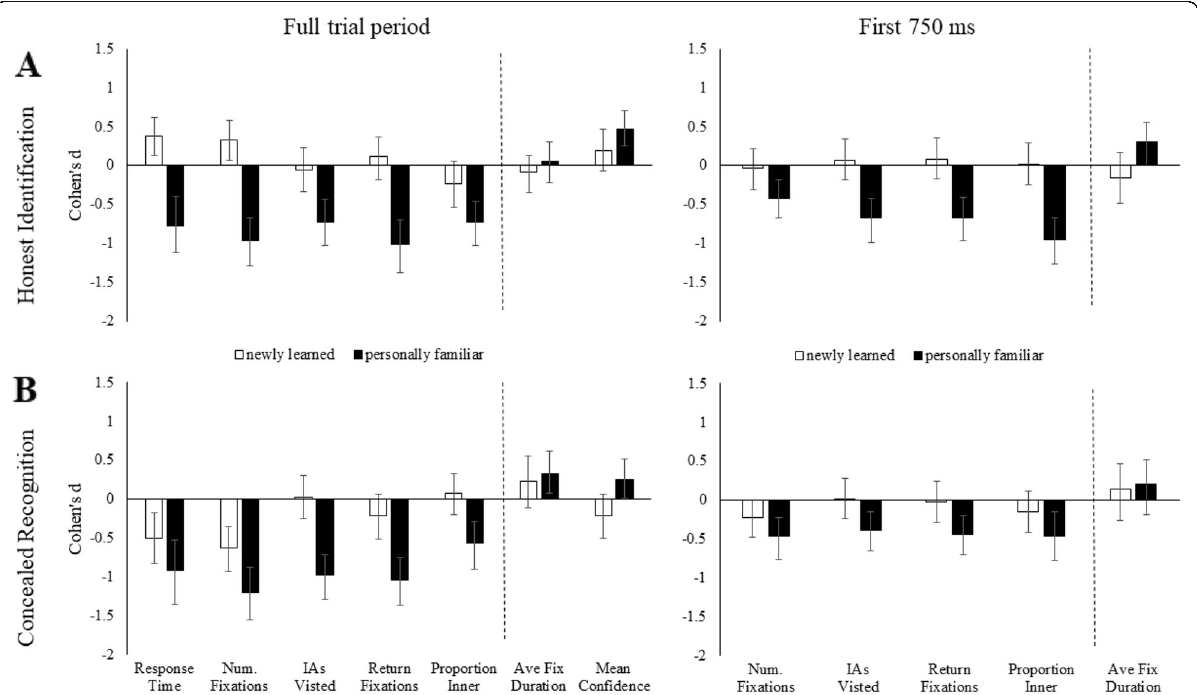
Fig. 3 Cohen ’ s d effect size differences (95% CIs) for faces in Experiment 1 a honest identification of familiar faces compared to unfamiliar faces, b concealed recognition of familiar faces compared to unfamiliar faces. On the left , data shown for the Full trial period are Response Times, Num. Fixations, IAs Visited, Return Fixations, Proportion Inner, Ave Fix Duration, Mean Confidence. On the right , we show re-analysis of the five fixation markers for the First 750 ms of the trial: Num. Fixations, IAs Visited, Return Fixations, Proportion Inner, Ave Fix Duration. Cohen ’ s d effect sizes are shown for comparisons between personally familiar faces and unfamiliar faces ( black bars ) and newly learned faces compared to unfamiliar faces ( white bars ). Tests of equality for effect sizes between honest and concealed conditions are presented in Supplementary Material Table